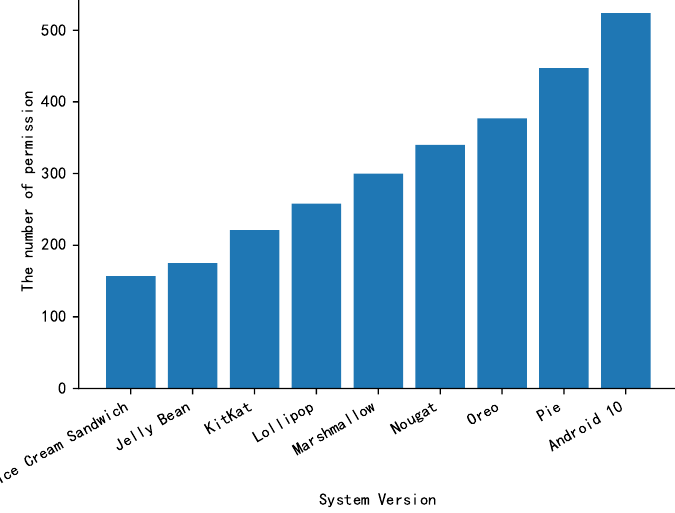
Figure 8. The number of permissions between Android 4.0 and